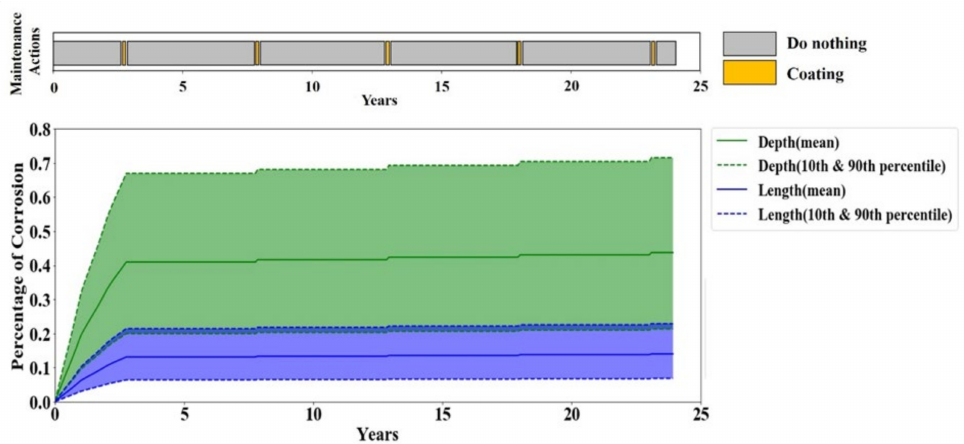
Figure 10. Corrosion depth and length in one 24-year full life evaluation episode for sensitivity scenario